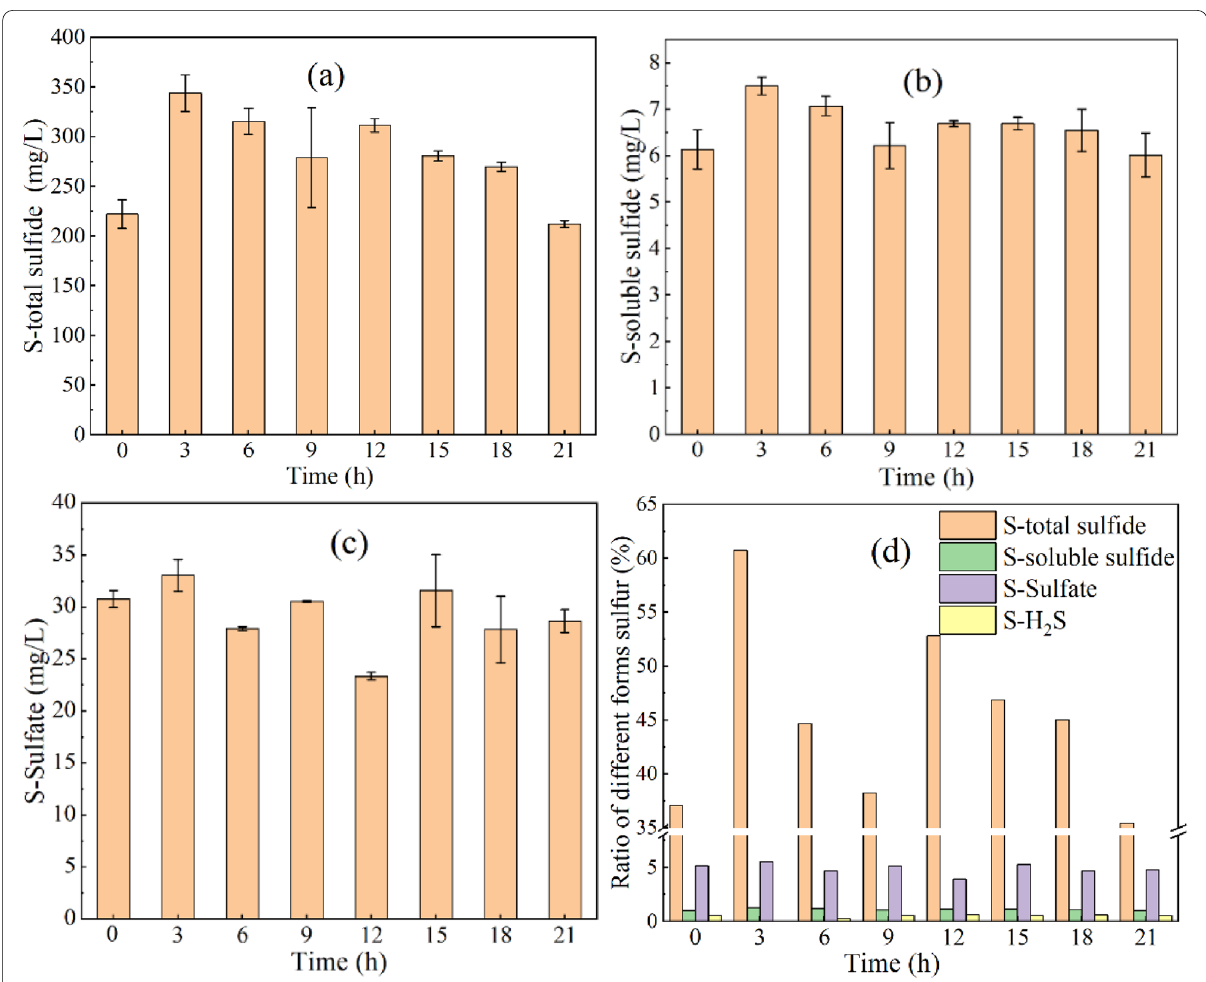
Fig.5 Changes in the forms of sulfur before and after feeding: a S-total sulfide; b S-soluble sulfide; c S-sulfate; d percentage value in the figure is the proportion of each form of sulfur to total